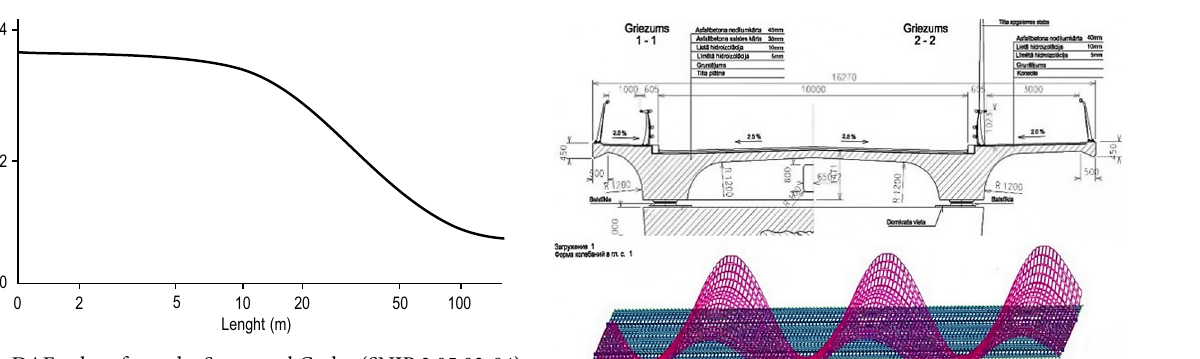
Fig. 4. DAF values from the Structural Codes (SNIP 2.05.03-84) previously used in Latvia (Gonzalez et al. 2009)